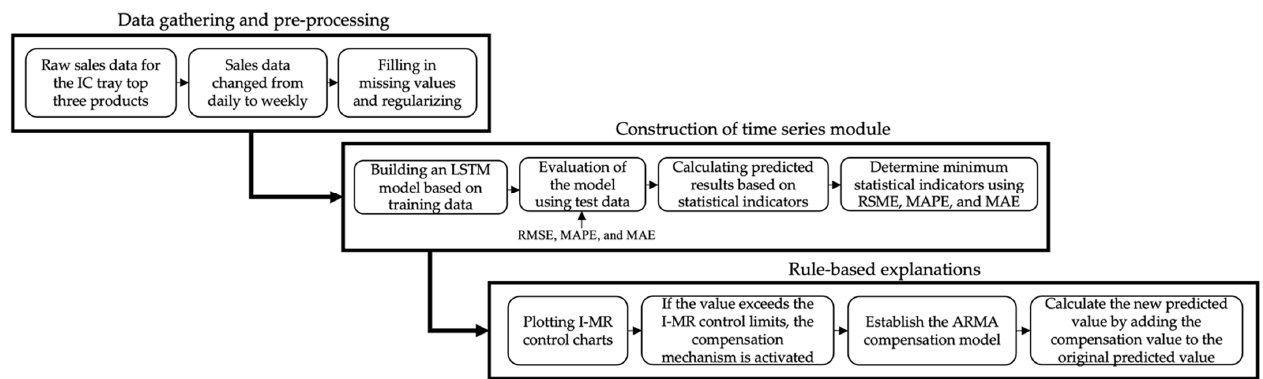
Figure 1. The analysis framework flowchart.